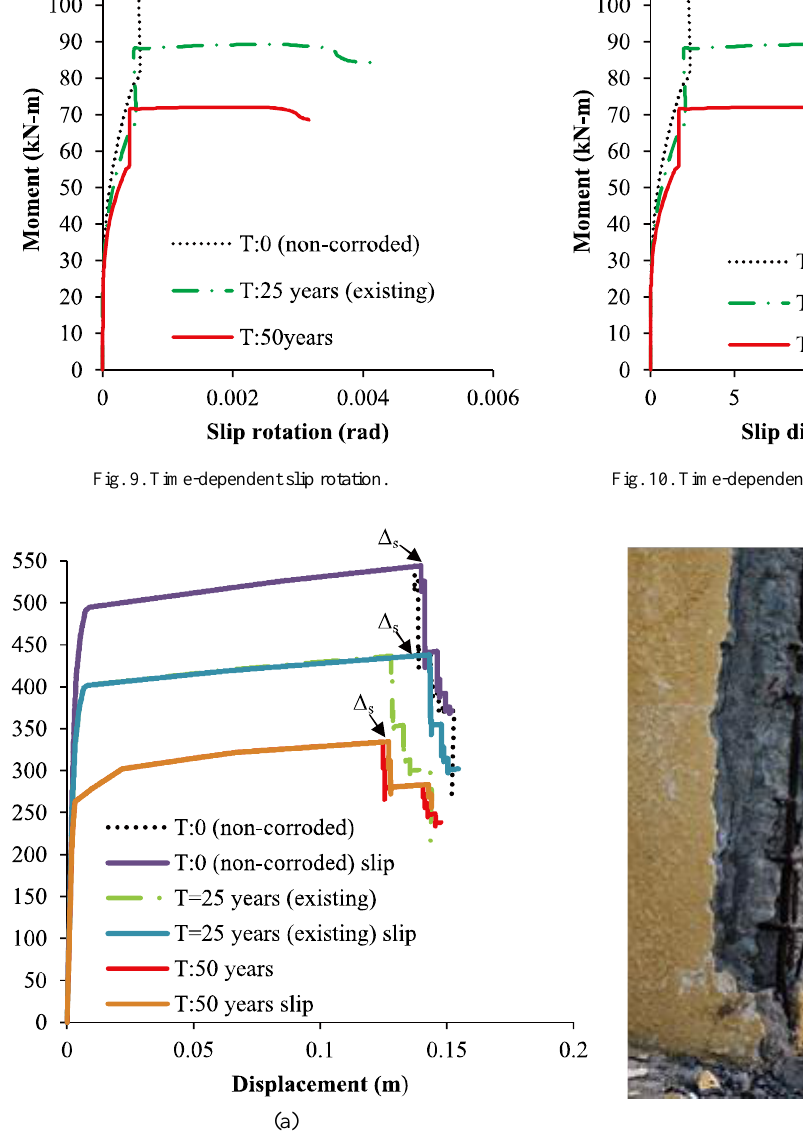
Fig. 11. (a): Time-dependent capacity curves by bond-slip relationships, (b): Slip